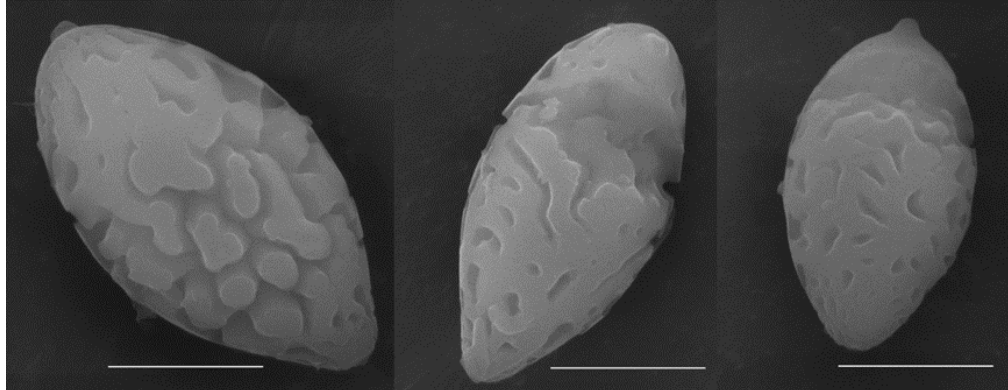
Figure 4. SEM of basidiospores from a dried specimen of Austroboletus brunneisquamus (FHMU5876, holotype). Bars = 5 μm. Mycobank: